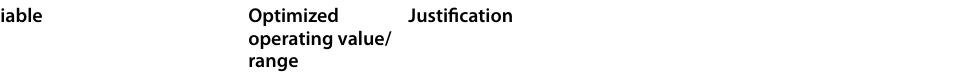
operating value/ range